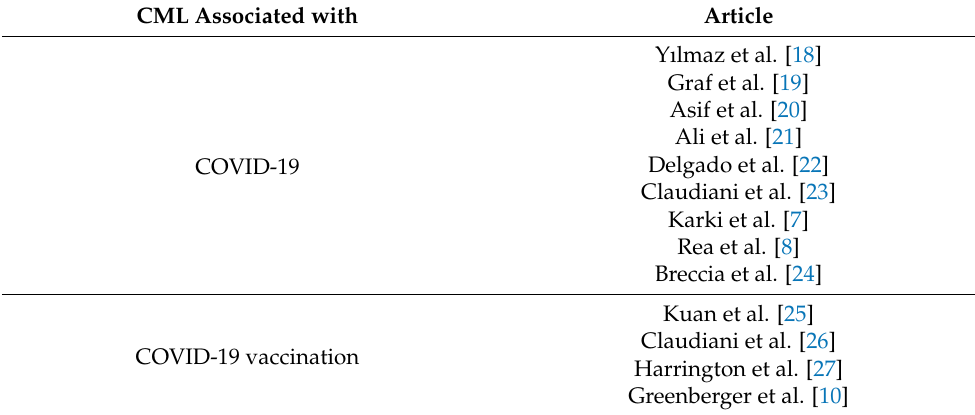
Table 1. Recent articles on CML and COVID-19 or COVID-19 vaccination.